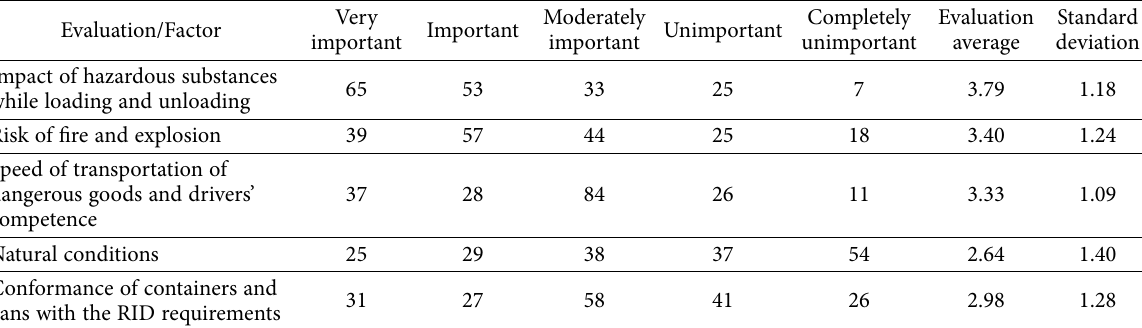
Table. The evaluation of the factors indicated by the respondents